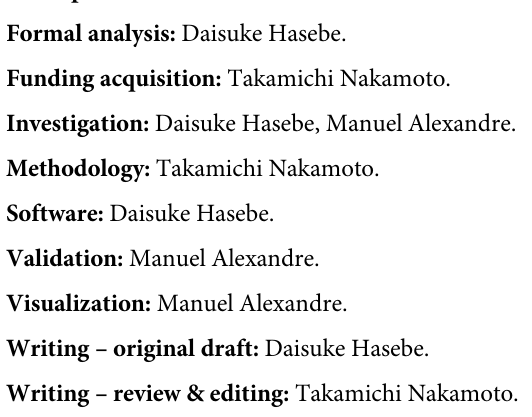
S1 Fig. Mass spectrum search from explored mass spectrum feature. S1 Table. Molecule IDs listed in Fig 10. S2 Table. Molecular IDs listed in Fig